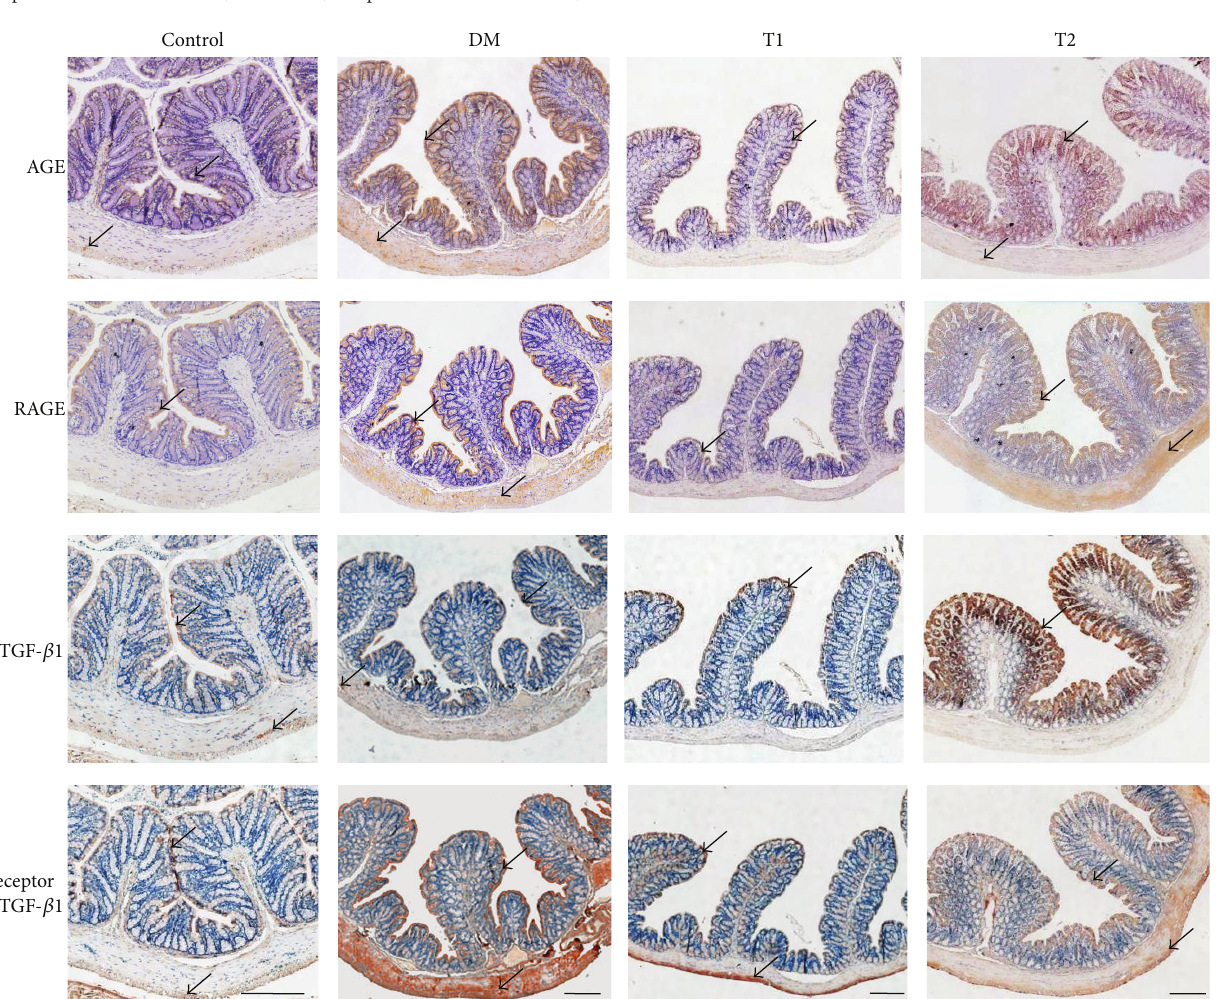
Figure 1: The representative samples of immunohistochemical staining for AGE, RAGE, TGF- 𝛽 1, and TGF- 𝛽 1 receptor in different groups. The brown color indicated positive staining and the arrows were to point the examples where the immunostaining is positive. The staining of all proteins was stronger in the muscle layer than other layers. The staining of AGE, RAGE, TGF- 𝛽 1, and TGF- 𝛽 1 receptor in different layers was stronger in the DM group than in Con group. Treatment with a high dosage of CRT (T1 group) partially reversed the abnormal expressions of different proteins in the different layers of the colon wall; however they did not significantly change in the T2 group. Bar =